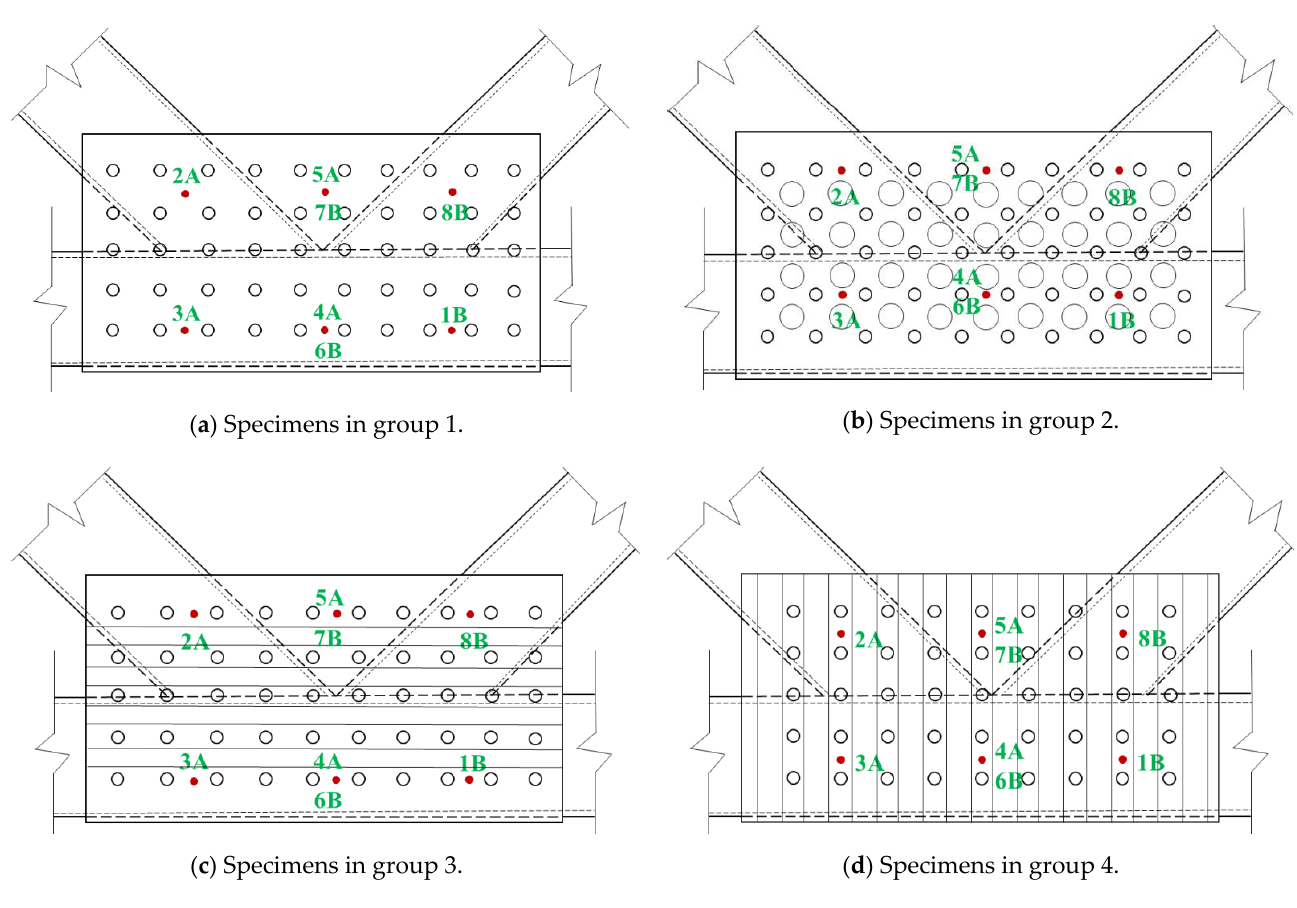
Figure 11. Deployment of displacement transducers of the K-joint specimen.